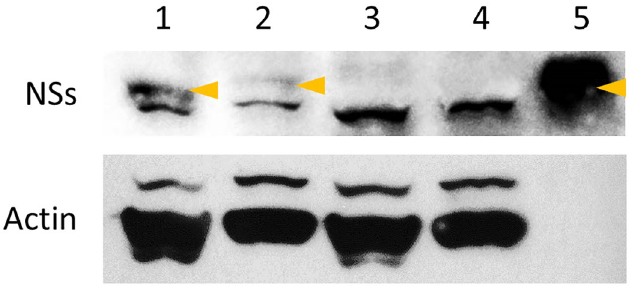
Fig 4. Western blot analysis of WSMoV NSs protein in viruliferous T . palmi . NSs protein with a molecular size of about 50 kDa was detected from the protein extract of viruliferous thrips. Western blotting of Actin in T . palmi was conducted as loading control. Lanes: 1, 20 viruliferous females; 2, 20 viruliferous males; 3, 20 non-viruliferous females; 4, 20 non-viruliferous males; 5, WSMoV-infected watermelon leaf. Arrowheads point to NSs protein.